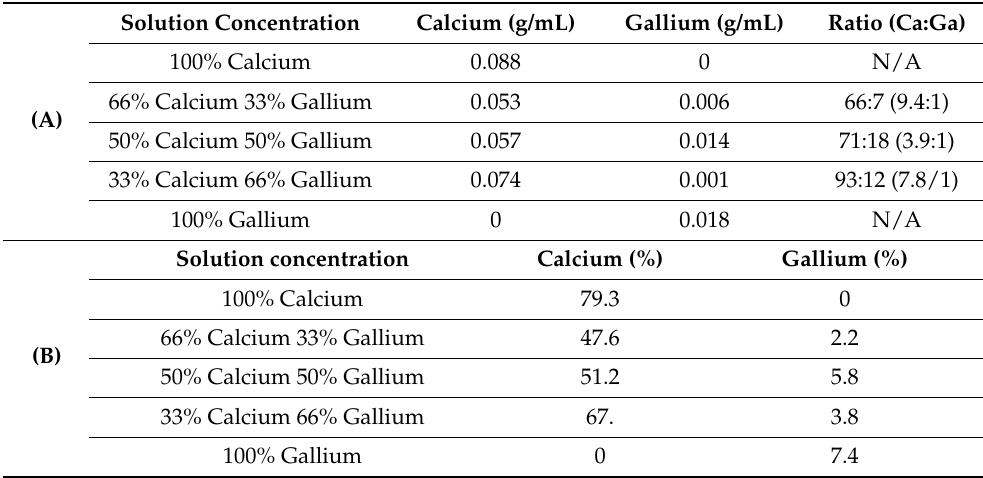
Table 3. (A) Cross-link cation quantities and ratios within the alginate matrix. (B) Relative ion transfer from external ion source into the alginate